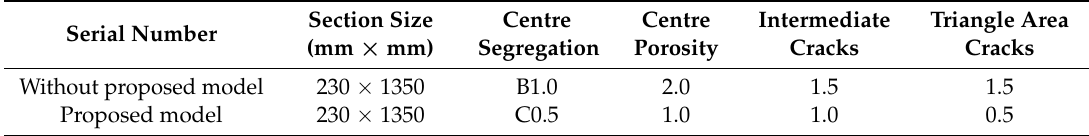
Table 4. Comparison of quality rating.